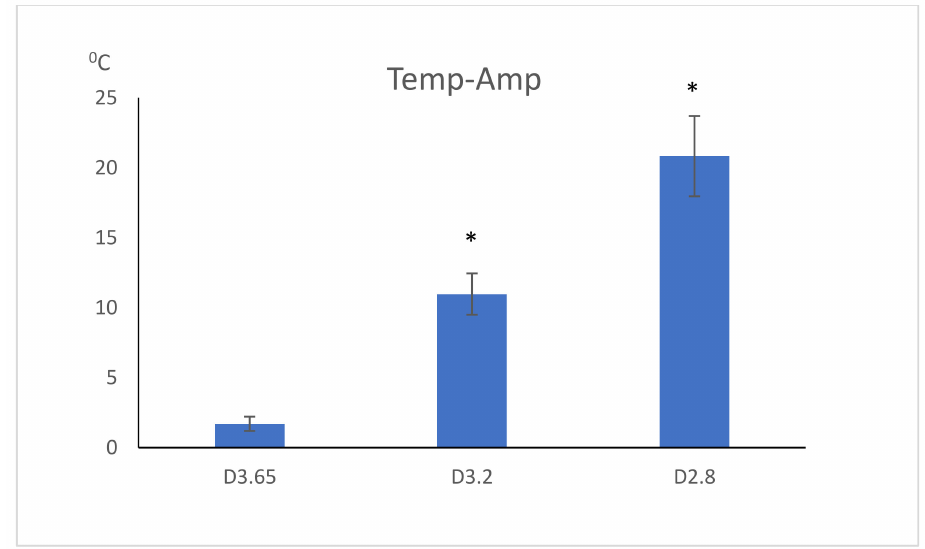
Figure 8. Implant surface temperature amplitude (Temp-Amp) for the di ff erent study groups. The amplitude was calculated by subtracting the room temperature from the measured implant surface temperature. The values are represented as averages and standard errors. * denotes p <